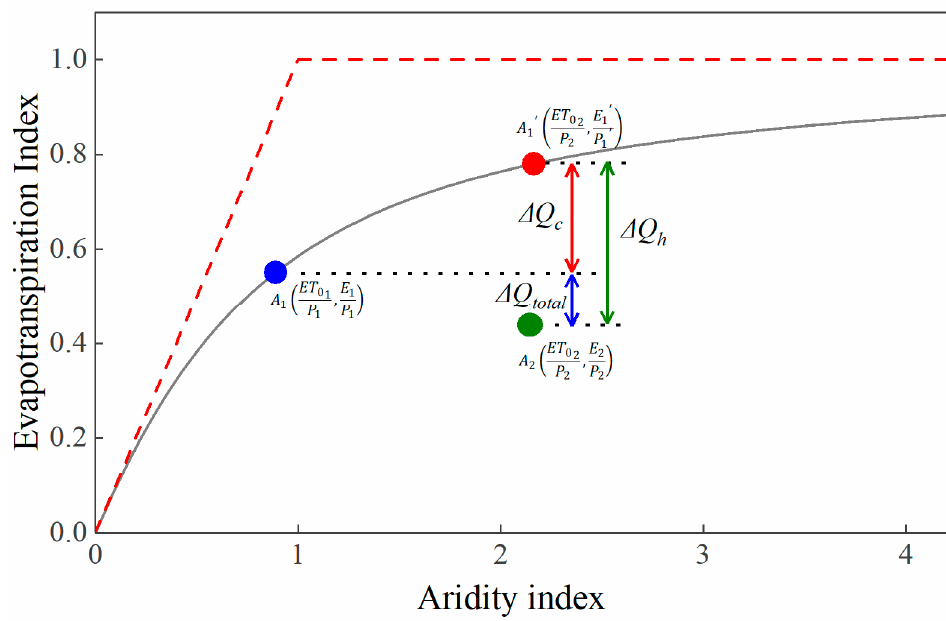
Figure 3. Decomposition method based on the Budyko framework (modified from Berghuijs and Greve [71]). A 1 represents the basin state in the reference period, A 2 represents the basin state in the human activities interference period, and A 1 ′ represents the basin state only under the influence of climate change.